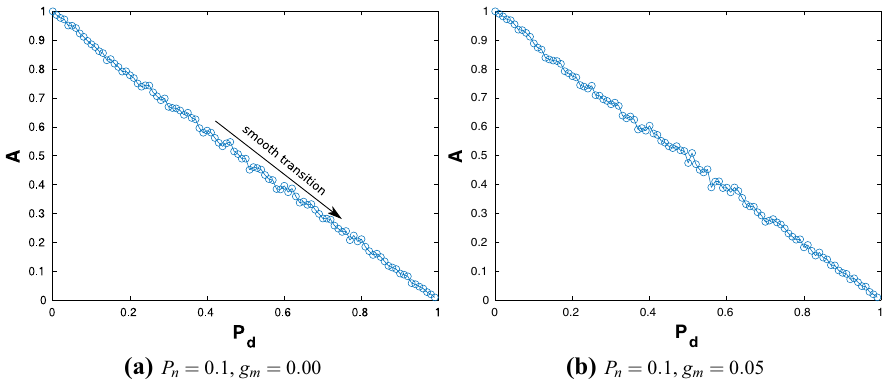
Figure 1. The order parameter A plotted as a function of P d for P n = 0.1 and ( a ) g m = 0.0 and ( b ) g m = 0.05 exhibiting smooth